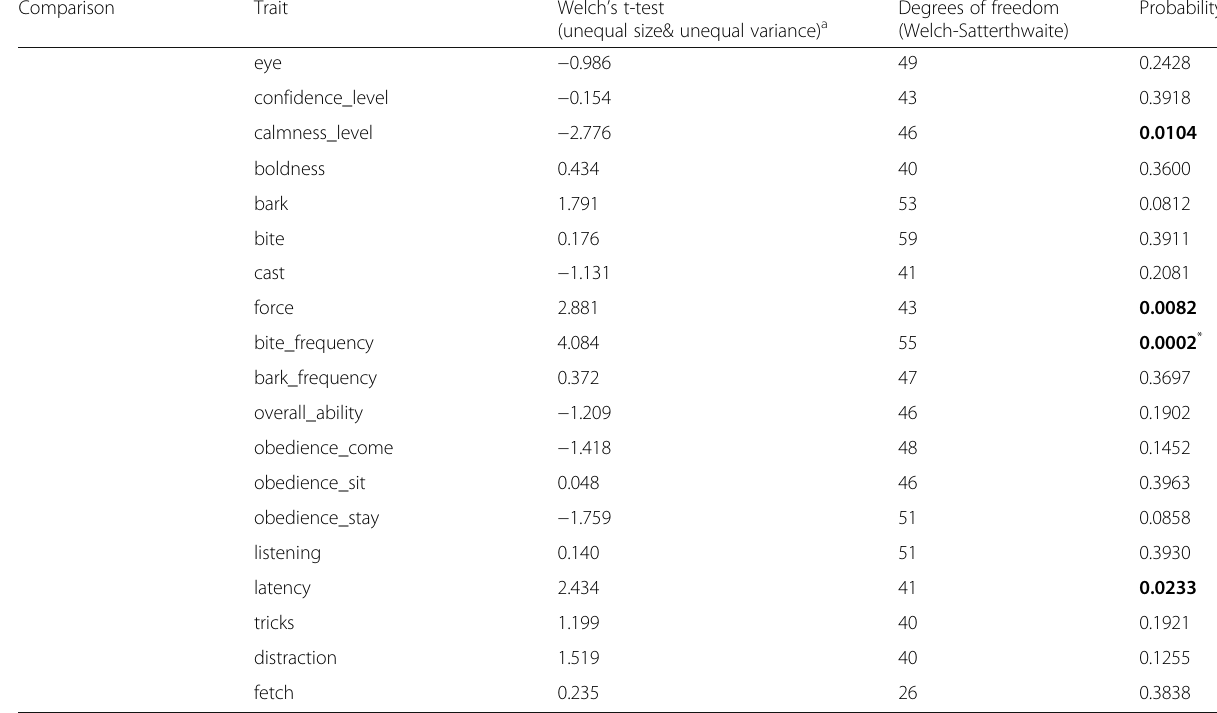
Table 1 Pairwise comparison of work-type in the Australian Working Kelpie over 63 traits (Continued)